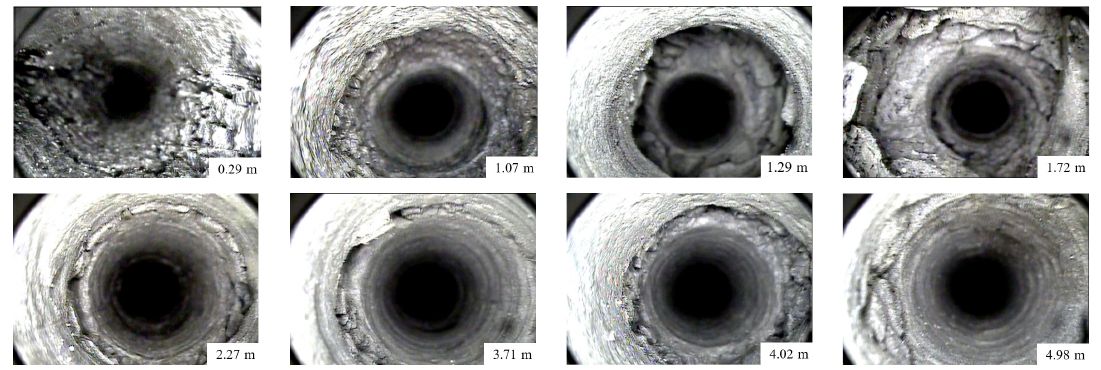
Figure 6. Borehole imaging of roof ‐ surrounding rock of RAR 23204.